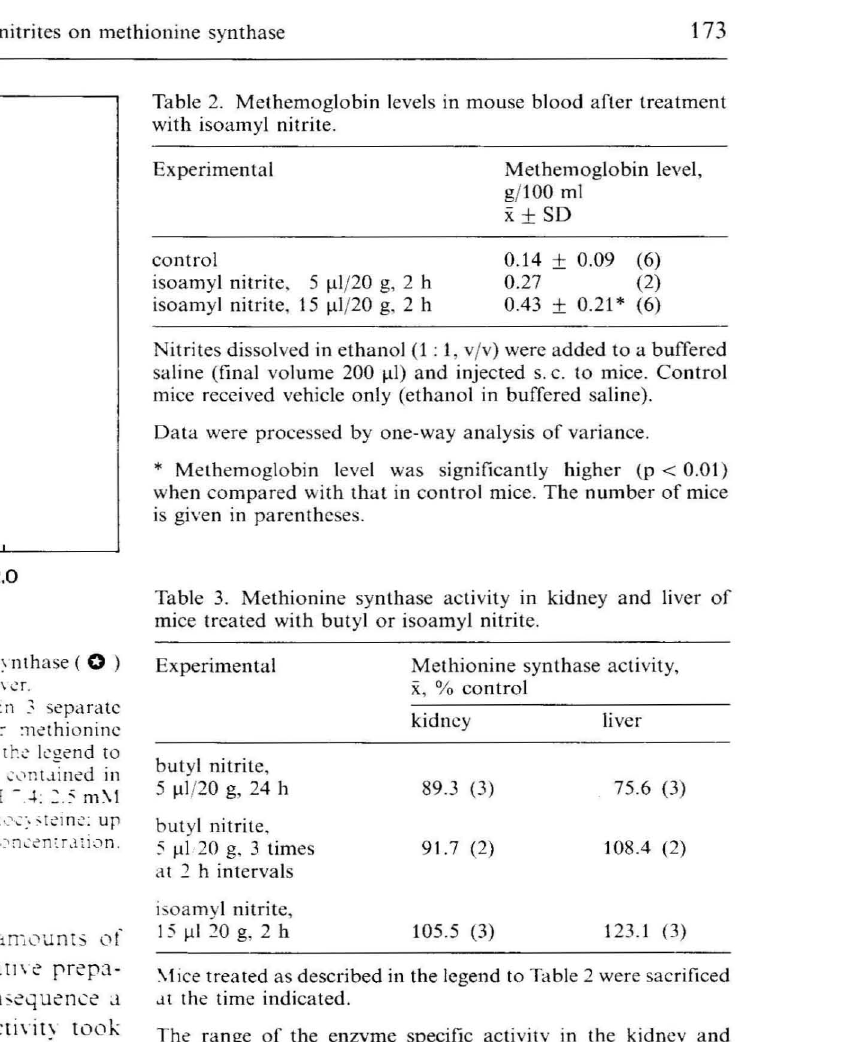
Figure 2. Effect of isoam: 1 T::-::: ,' :, :r.::<-':L'lnl~ 5\'11lhase ( 0 ) and betainc methyltran,fcT.,,: . & . :'~,.':~: :~l·'~'~ II\<:L